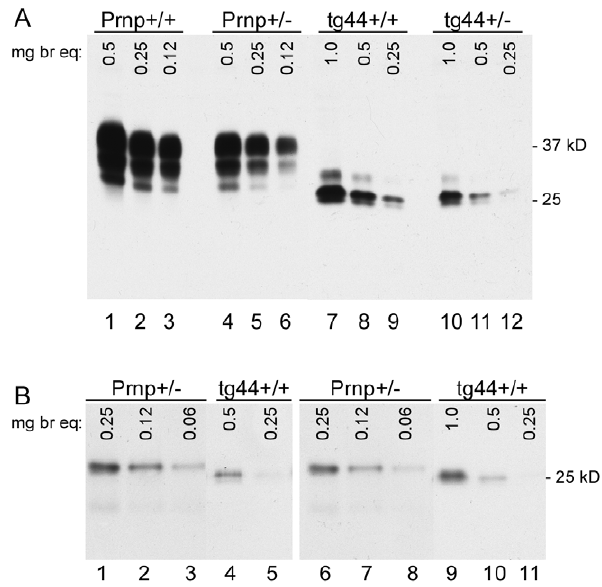
Figure 1. Brain PrPsen expression levels. C57BL/10 (Prnp + / + ), Prnp + / 2 , expressing normal anchored mouse PrP, and transgenic mice (tg44 + / + and tg44 + / 2 ), expressing only anchorless mouse PrP were compared. Immunoblots were done using brain homogenates made as described in methods, and samples were serially diluted two-fold in sample buffer to give the mg brain equivalents shown on the figure. Bands were detected with monoclonal antibody D13. (A) No PNGase digestion. Lanes 1–3: Prnp + / + , Lanes 4–6: Prnp + / 2 , Lanes 7–9: tg44 + / + and Lanes 10–12: tg44 + / 2 . (B) After PNGase F treatment. Lanes 1–3: Prnp + / 2 , Lanes 4–5: tg44 + / + , Lanes 6–8: Prnp + / 2 and 9–11: tg44 + / + mice. Lanes 1–5 were from one experiment and 6–11 were from a separate experiment and results shown are for 4 different mice. Lower apparent molecular weight in PrP of transgenic mice is due to lack of the GPI anchor. Prnp + / 2 mice appeared to have 4-fold more brain PrPsen than tg44 + / + mice (compare lanes 2 and 4, also lanes 7 and 10). Data shown are for tg44 + / + and tg44 + / 2 mice. By immunoblot PrPsen expression levels in tg23 mice were indistinguishable from those in tg44 mice (data not